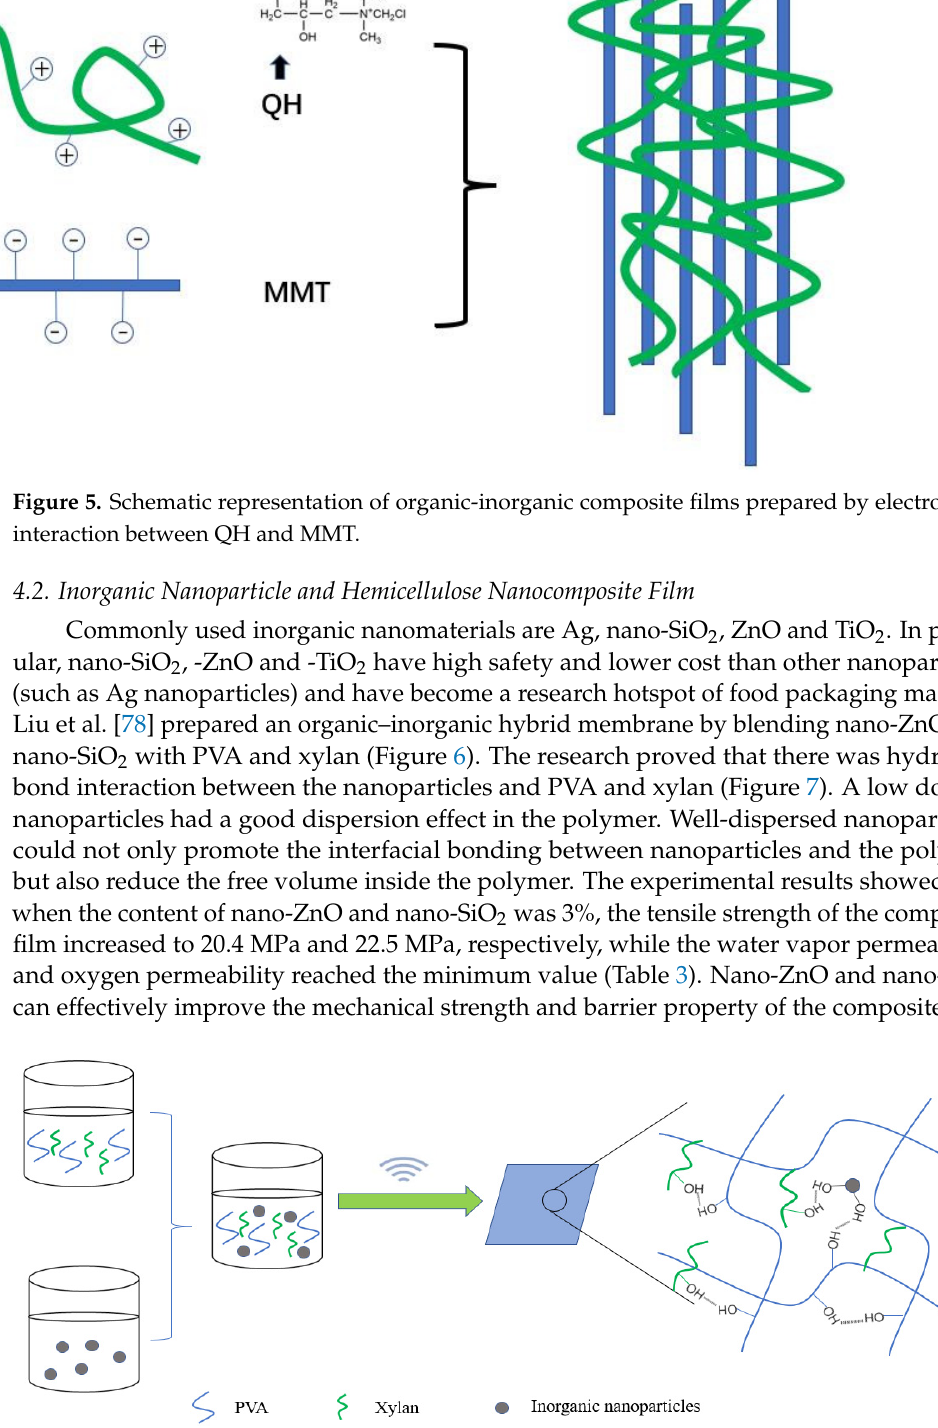
Figure 7. Hydrogen bond interaction between nano-ZnO particles and PVA/xylan composite film. Organic films have low density and high flexibility. Inorganic particles mixed into organic films not only play a strengthening and barrier effect but also make the composite film have the unique properties of inorganic particles. Food packaging materials should have a shielding effect against incoming and outgoing ambient gases and ultraviolet light [99]. Some nanofillers can act as ultraviolet shields and absorb harmful radiation [100]. Nano-TiO 2 has the advantages of high stability, nontoxicity, low cost, photocatalytic ac- tivity and UV shielding. It can be divided into rutile nano-TiO 2 and anatase nano-TiO 2 according to its crystal form. Rutile TiO 2 is widely used in the fields of food packaging and wastewater treatment because of its high scattering effect and good shielding effect against ultraviolet light. Ren and colleagues [79] studied the influence of different crystal